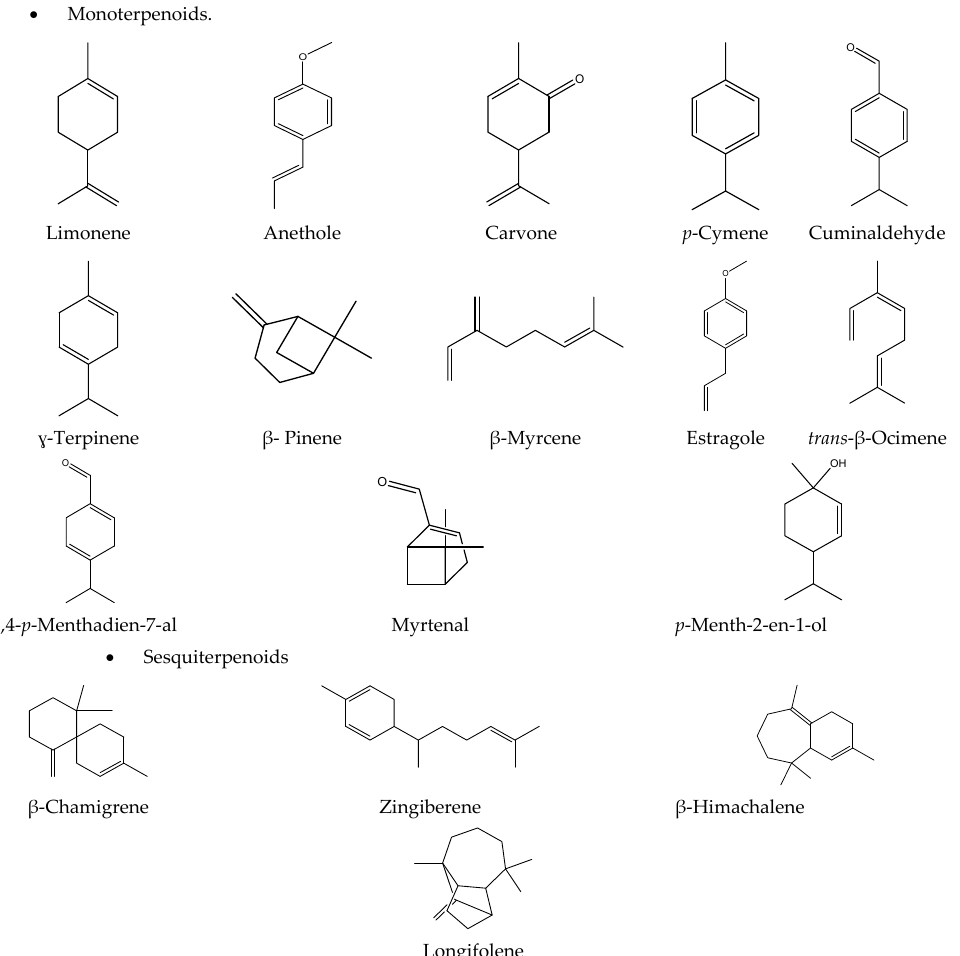
Figure 2. 2D structures of the main detected compounds of three oils L. by GC–MS analysis (Drawn by Chem ‐ draw ultra ‐ version 14). Table 2. Mean of H. pylori inhibitory % of three extracted essential oils against the standard drug clarithromycin. Sample conc. ( µ